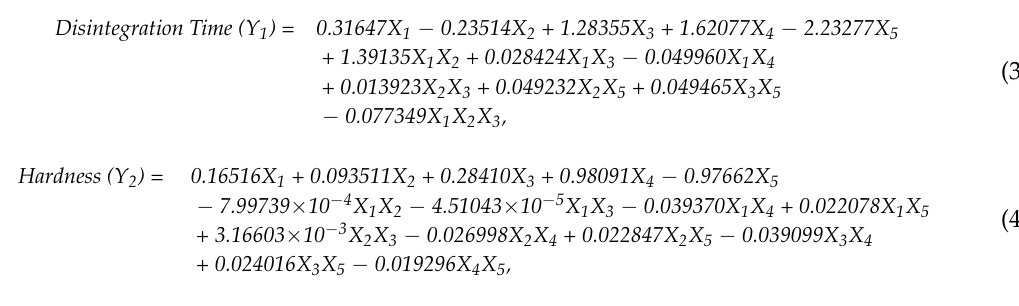
Table 5. The reduced special cubic model was statistically significant in describing the disintegration time, whereas the quadratic model was fit well in tablet hardness. Mathematical models for the disintegration time and hardness were provided by equations (3) and (4).